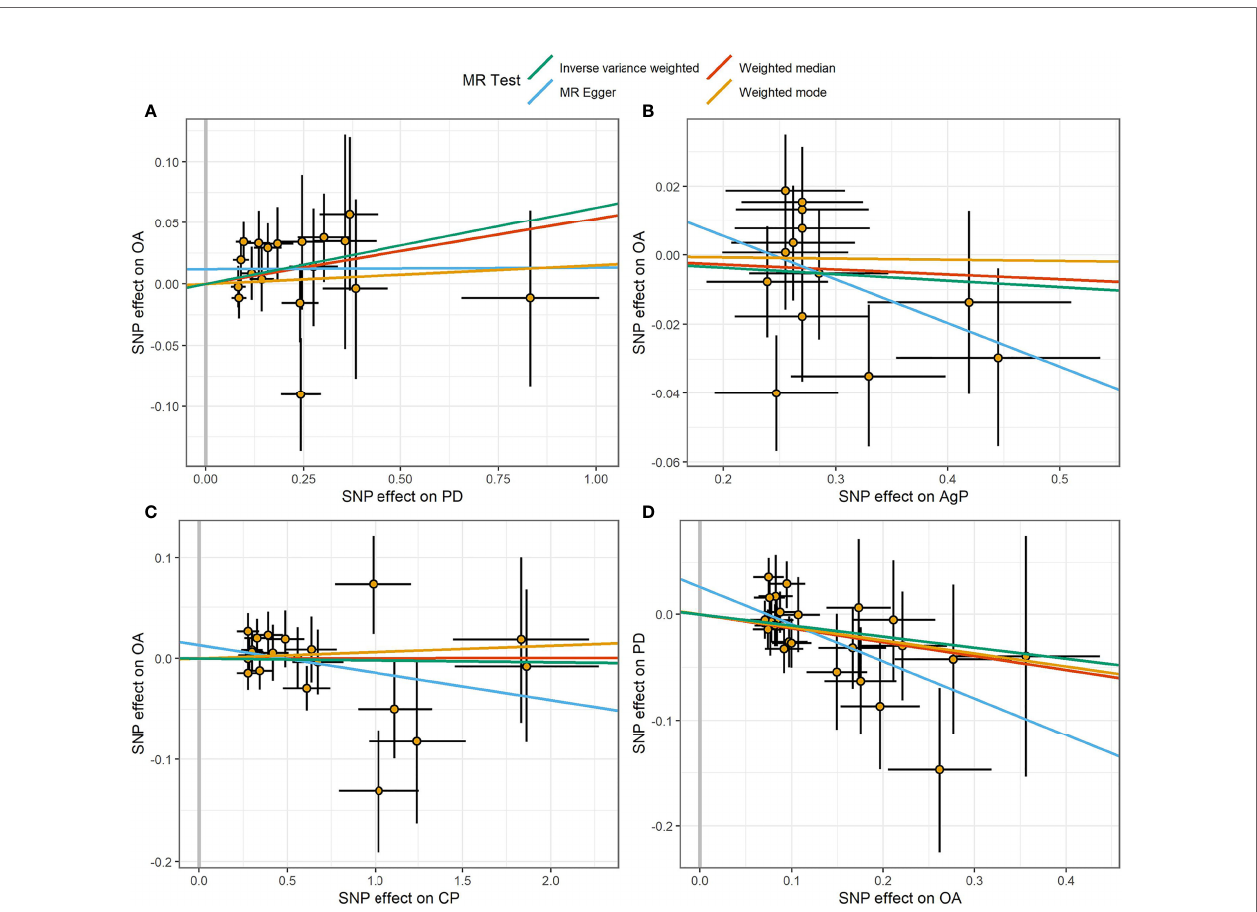
FIGURE 3 | Scatter plot of the causal relationships between OA and PD using different MR methods. (A) Causal estimates for PD on OA. (B) Causal estimates for AgP on OA. (C) Causal estimates for CP on OA. (D) Causal estimates for OA on PD. The slope of each line corresponding to the causal estimates for each method. Individual SNP-effect on the outcome (point and vertical line) against its effect on the exposure (point and horizontal line) was delineated in the